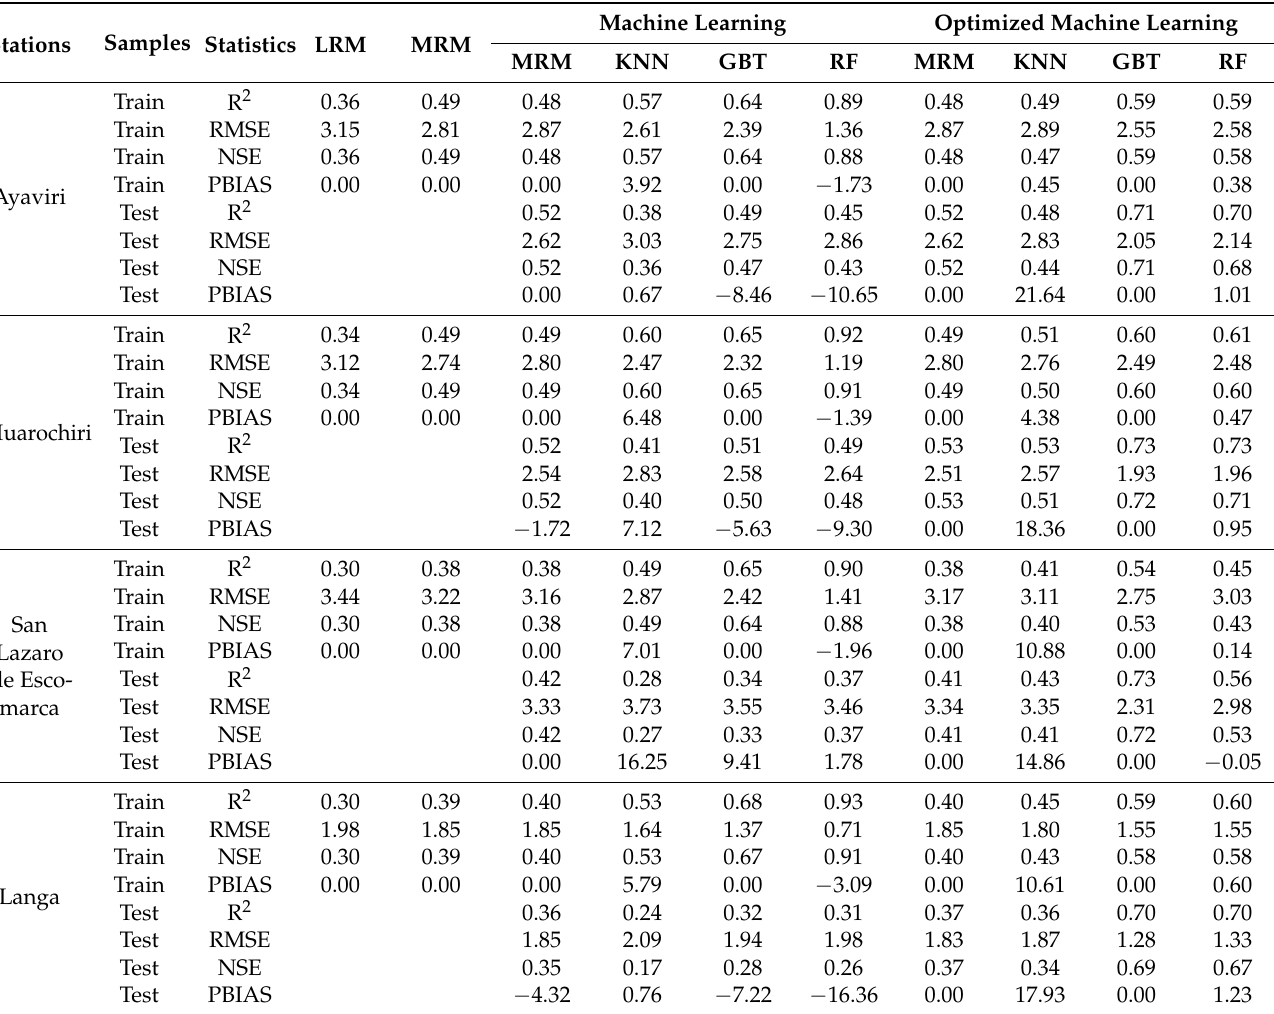
Table 7. Model efficiency according to fit statistics—Region